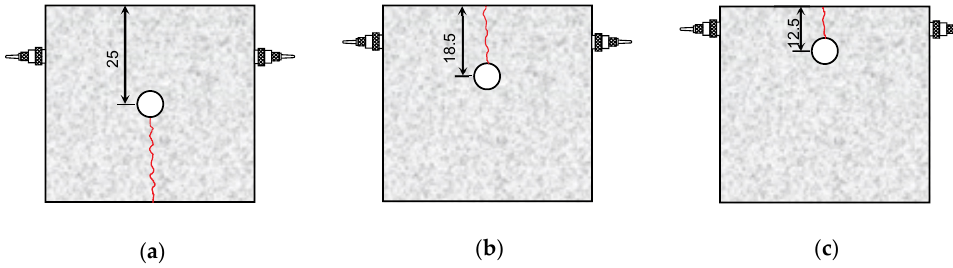
Figure 6. Schematic drawings of three rock specimens configured with transducers at hole-to-face distances of: ( a ) 25 cm; ( b ) 18.5 cm; ( c ) 12.5 cm. The numbers are in centimeter units.